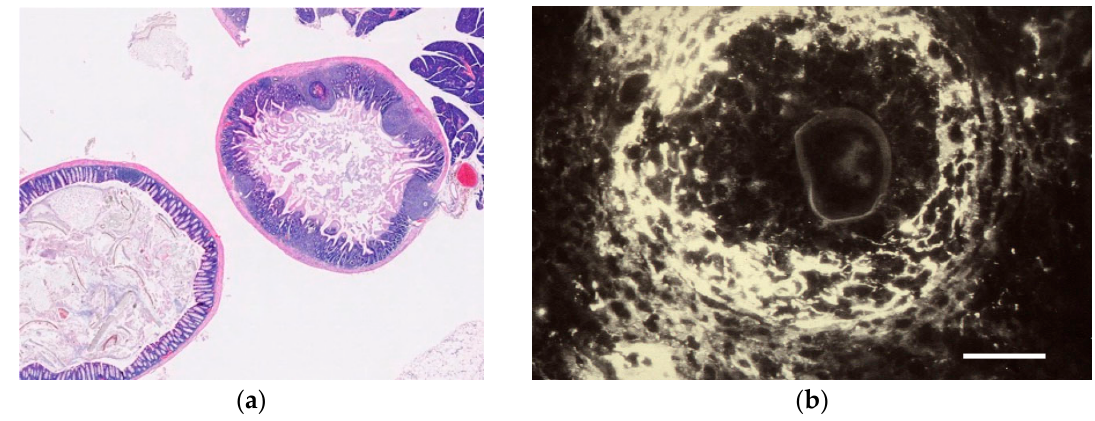
Figure 5. Perioval granulomas in intestinal wall of experimentally infected mouse. ( a ) Paraffin section of intestinal wall stained with hematoxylin and eosin. Virtual microscopy view at 10× magnification: See Webmicroscope for Parasitology [43]. ( b ) Plasmin in periphery of perioval granuloma shown by immunofluorescence. Note slight autofluorescence of eggshell. The perioval host response involves tissue destruction and formation of a tissue channel, in which the egg will be transported through host tissues into the excreta [44]. Bar equals 100 microns.